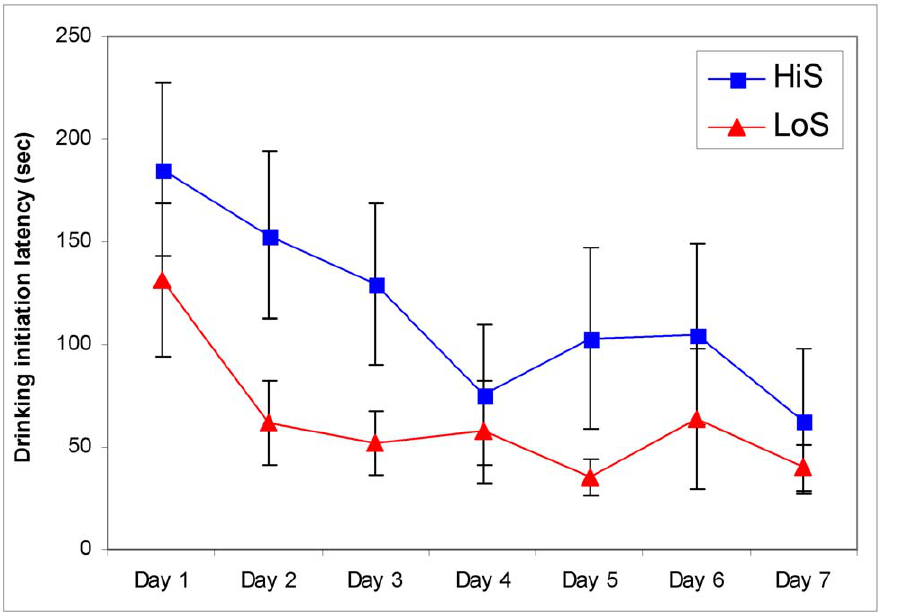
Figure 3. Control study data: Experimentally naı¨ve, solitary rats’ latency to drink milk for a total of 5 s on each test day. Drinking initiation differed marginally across days and between lines. doi:10.1371/journal.pone.0046606.g003 PLOS ONE |